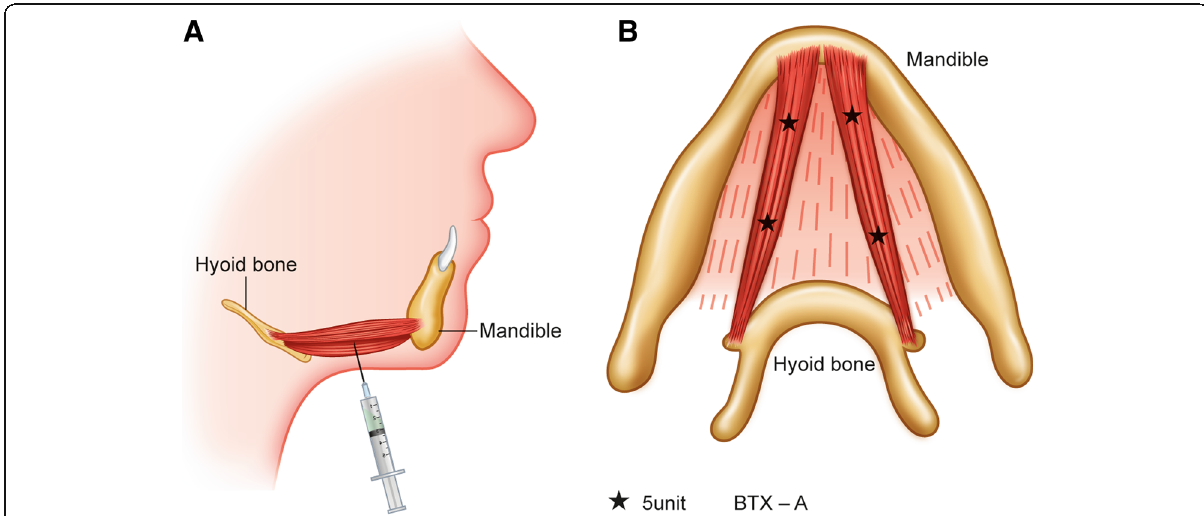
Fig. 1 A schematic illustration of the procedure. a Injection into the anterior belly of the digastric muscle was performed using a submental approach. b The injection points are shown. Each point received 5units of